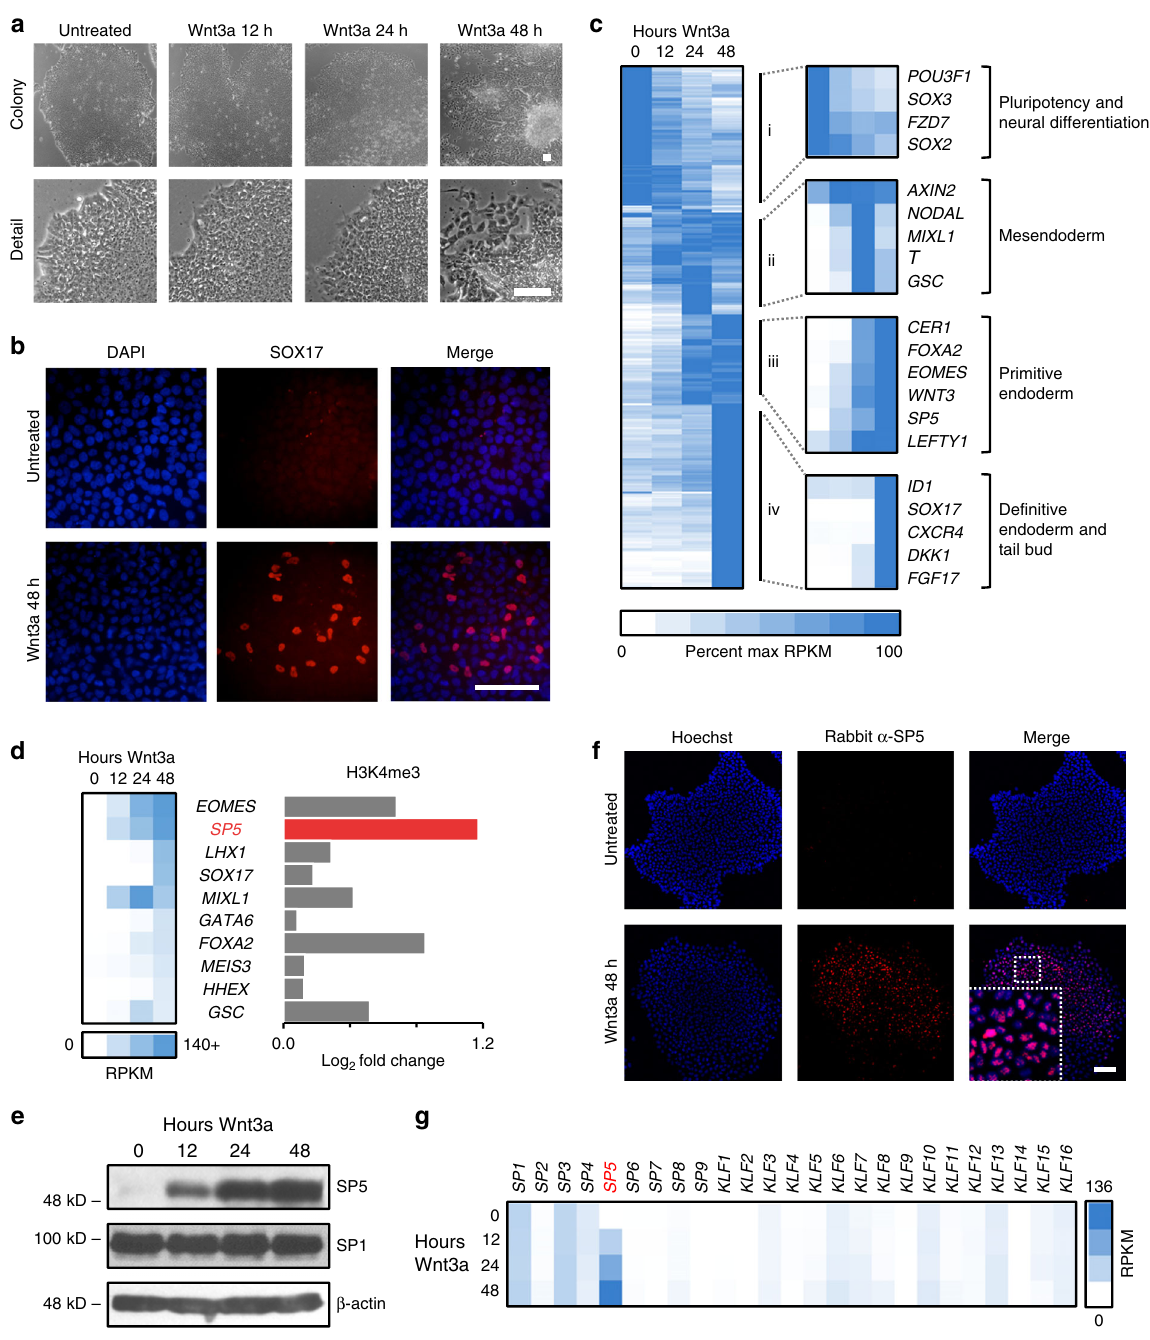
Fig. 1 Identi fi cation of SP5 as a highly responsive WNT/ β -catenin target gene in hPSCs. a Cell morphology changes in response to Wnt3a treatment. HESCs (H1/WA01) were treated with 1 nM Wnt3a for the indicated times and imaged using phase contrast microscopy. Scale bar = 100 μ m. b Immuno fl uorescence (IF) for a differentiation marker. hESCs were treated with 1 nM Wnt3a for 2 days and analyzed by IF for SOX17 expression. Scale bar = 100 μ m. c Heatmap of genes with signi fi cant changes in expression upon Wnt3a treatment. HESCs were treated with 1 nM Wnt3a for the indicated times and RNA was isolated and analyzed by RNA-Seq. About 511 genes with signi fi cant differential expression in response to Wnt3a fell into four main clusters i – iv. Refer to Supplementary Data 1 for complete gene set. d Transcription factors with greatest differential expression in response to Wnt3a. The top 10 genes encoding transcription factors were sorted by percent maximum reads per kilobase per million mapped reads (RPKM). ChIP-Seq analysis indicated that the SP5 promoter region shows a signi fi cant change in the histone mark H3K4me3 upon Wnt3a signaling. Supplementary Fig. 1c, d provides additional information about these transcription factors and display the genome browser tracks of all 10 genes for this histone mark. e SP5 protein accumulation in response to Wnt3a treatment. HESCs were treated with 1 nM Wnt3a for the indicated times and nuclear extracts were immunoblotted for SP5, SP1, or β - actin (a loading control). kD kilo Daltons. f Immuno fl uorescence of SP5. HESCs were treated with Wnt3a (1 nM) for 24 h and cells were fi xed and stained for SP5 (red, rabbit anti-SP5) and DNA (blue, Hoechst). Untreated cells were incubated with an equivalent volume of WNT storage buffer. Scale bar = 100